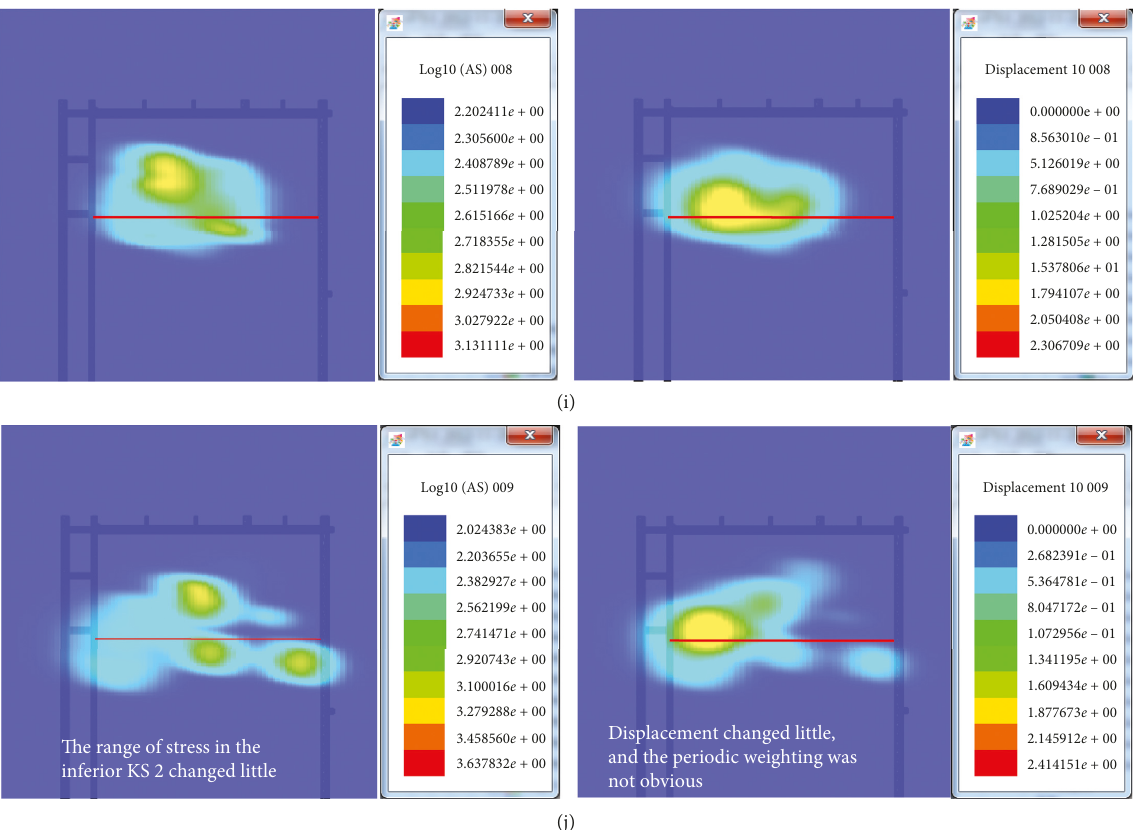
Figure 7: Cloud charts of apparent stress and displacement in inferior KS 2. (a) Aug 31, (b) Sep 1, (c) Sep 3, (d) Sep 4, (e) Sep 5, (f) Sep 6, (g) Sep 7, (h) Sep 8, (i) Sep 9, and (j) Sep 10.